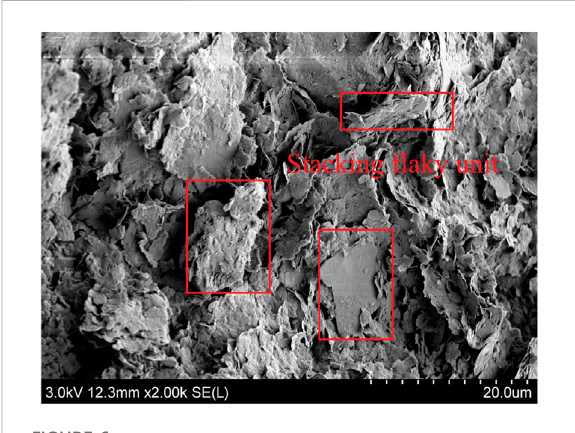
FIGURE 6 Scanning electron microscopy (SEM) photographs of undisturbed